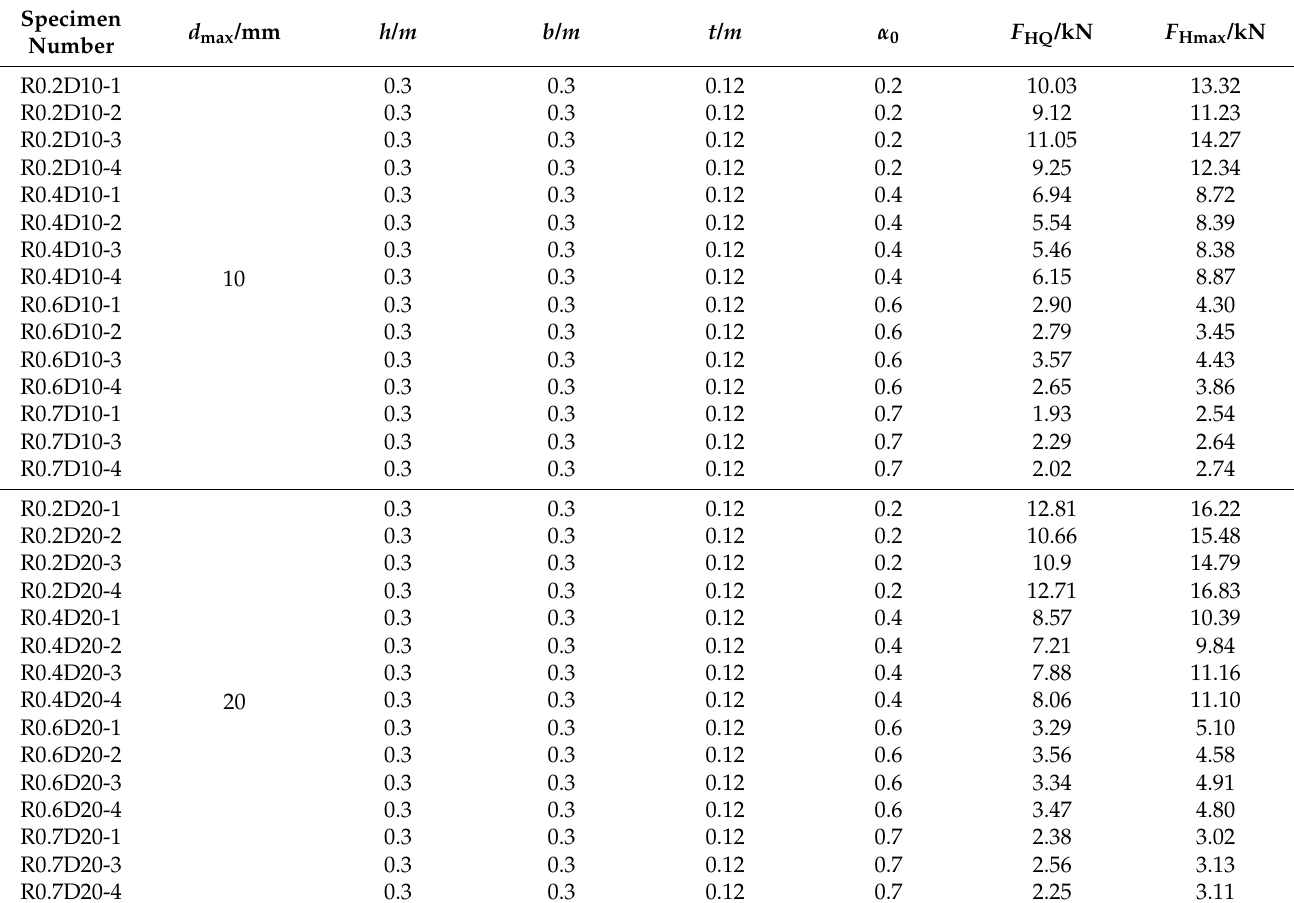
Table 3. Fracture test results reported in reference [57].